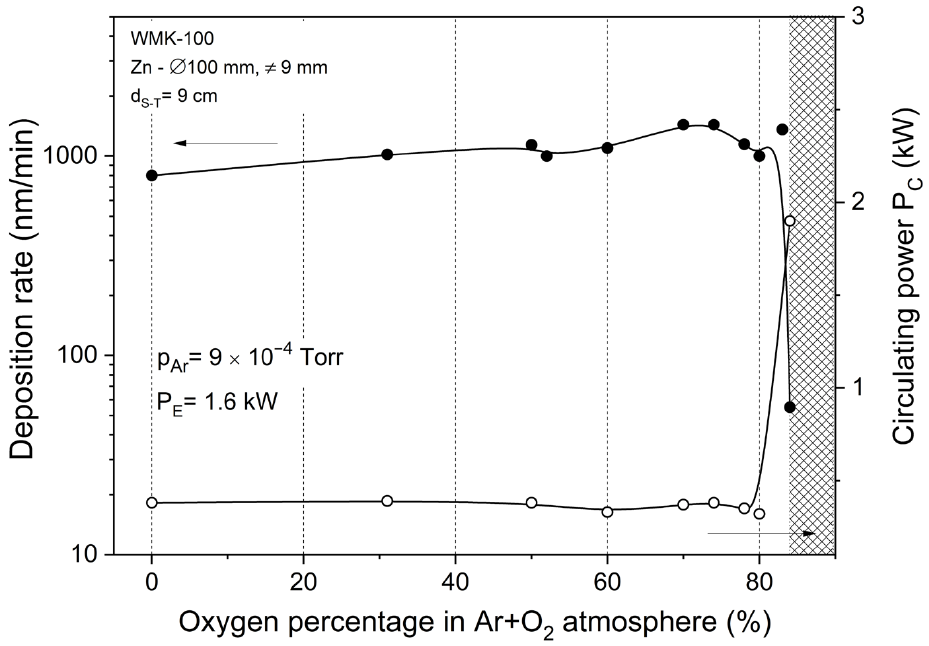
Figure 4. Influence of the percentage of oxygen content in the Ar:O 2 atmosphere on the deposition rate of the ZnOx films and circulating power.